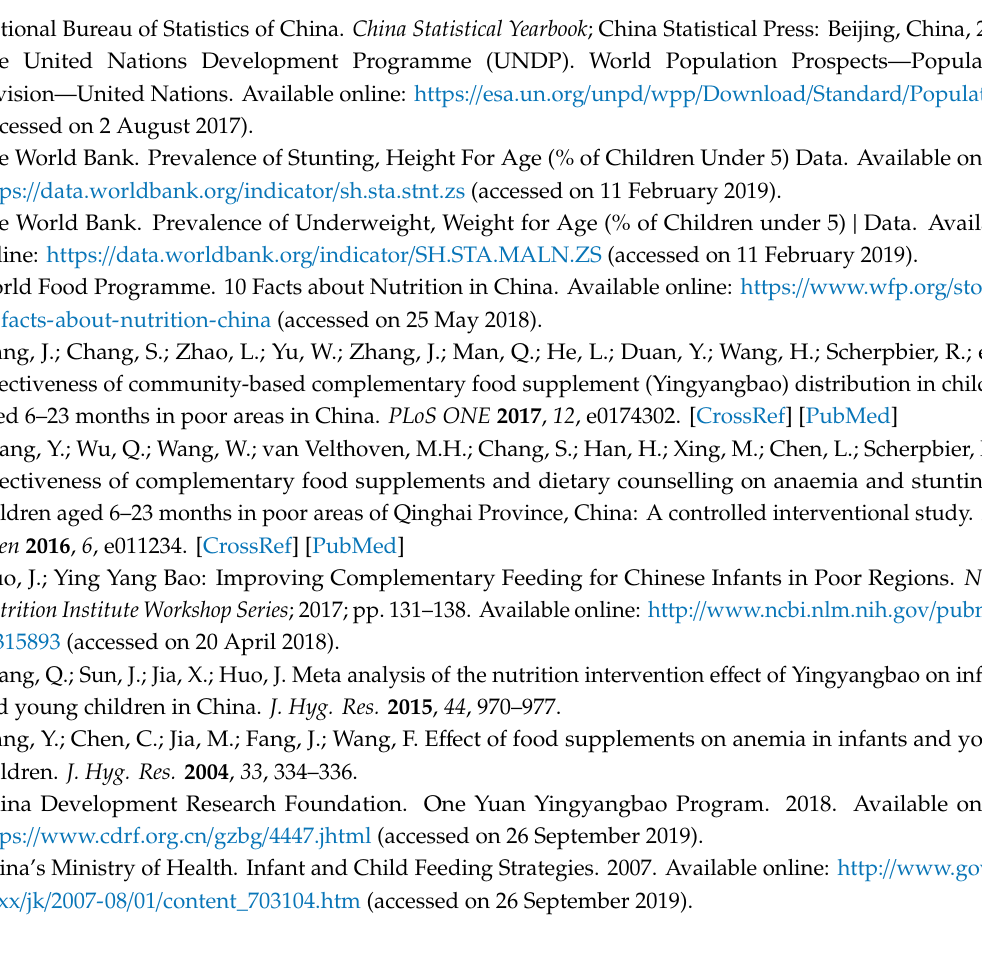
e ff ects of YYB on height-for-age z score (HAZ) among post-only studies with concurrent-control (a) and pre-post studies (b) using mean di ff erence as the e ff ect measure. Figure S5: The e ff ects of YYB on weight-for-height z score (WHZ) among post-only studies with concurrent-control (a) and pre-post studies (b) using mean di ff erence as the e ff ect measure. Figure S6: The e ff ects of YYB on weight-for-age z score (WAZ) among post-only studies with concurrent-control (a) and pre-post studies (b) using mean di ff erence as the e ff ect measure. Figure S7: The e ff ects of YYB on anemia prevalence among post-only studies with concurrent-control (a) and pre-post studies (b) using risk ratios as the e ff ect measure. Figure S8: The e ff ects of YYB on stunting prevalence among post-only studies with concurrent-control (a) and pre-post studies (b) using risk ratios as the e ff ect measure. Figure S9: The e ff ects of YYB on underweight prevalence among post-only studies with concurrent-control (a) and pre-post studies (b) using risk ratios as the e ff ect measurements. Figure S10: The e ff ects of YYB on wasting prevalence among post-only studies with concurrent-control (a) and pre-post studies (b) using risk ratios as the e ff ect measurements. Figure S11: The e ff ects of YYB on anemia prevalence among post-only studies with concurrent-control (a) and pre-post studies (b) using risk di ff erence as the e ff ect measure. Figure S12: The e ff ects of YYB on stunting prevalence among post-only studies with concurrent-control (a) and pre-post studies (b) using risk di ff erence as the e ff ect measure. Figure S13: The e ff ects of YYB on underweight prevalence among post-only studies with concurrent-control (a) and pre-post studies (b) using risk di ff erence as the e ff ect measure. Figure S14: The e ff ects of YYB on wasting prevalence among post-only studies with concurrent-control (a) and pre-post studies (b) using risk di ff erence as the e ff ect measure. Figure S15: Funnel plot of e ff ects of YYB on anemia prevalence among post-only studies with concurrent-control. Figure S16: Funnel plot of e ff ects of YYB on anemia prevalence among pre-post